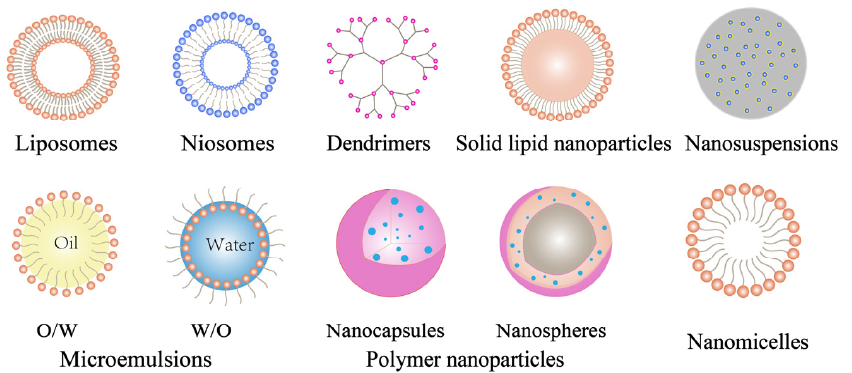
Figure 5. Schematic illustration of different nanoparticle eye drop delivery systems. The different nanoparticles include liposomes, niosomes, dendrimers, solid lipid nanoparticles, nanosuspensions, oil-in-water (O/W)- and water-in-oil (W/O)-type microemulsions, nanocapsule- and nanosphere- type polymer nanoparticles, and nanomicelles.